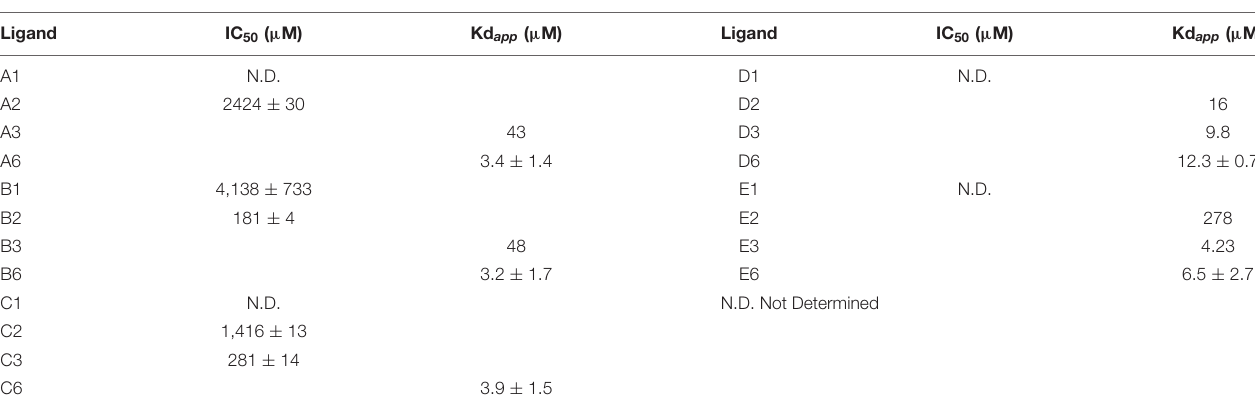
FIGURE 1 | Cartoon of the mannoside clusters. (A) A schematic overview of the 20 mannoside clusters. (B) Only the hexavalent clusters are further conjugated to a gp100 antigen. TABLE 1 | Binding affinity to the Langerin